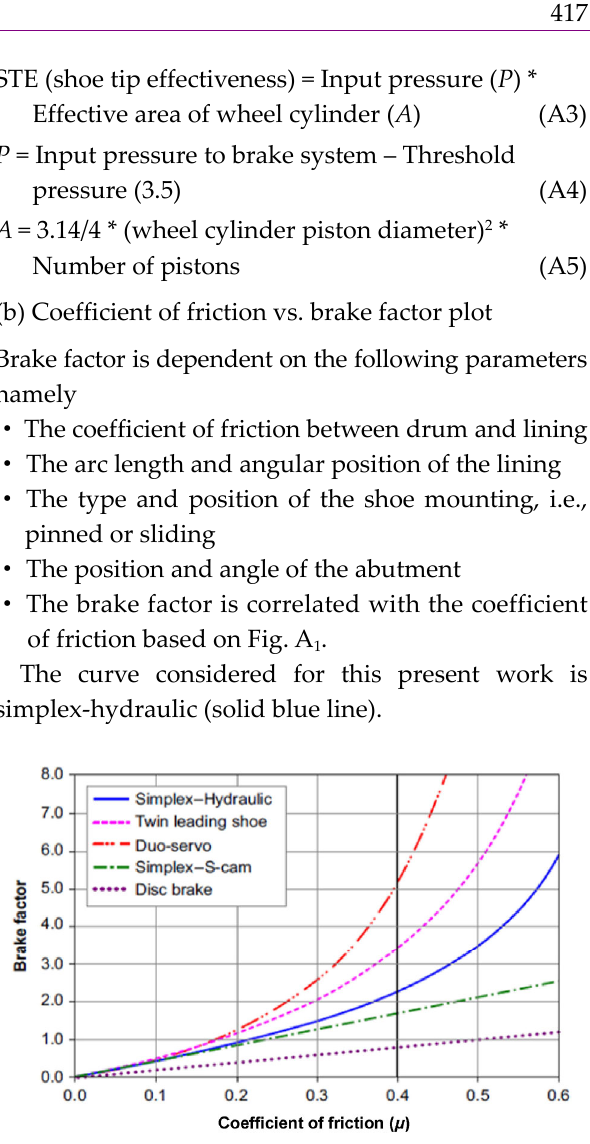
Fig. A 1 Coefficient of friction vs. brake